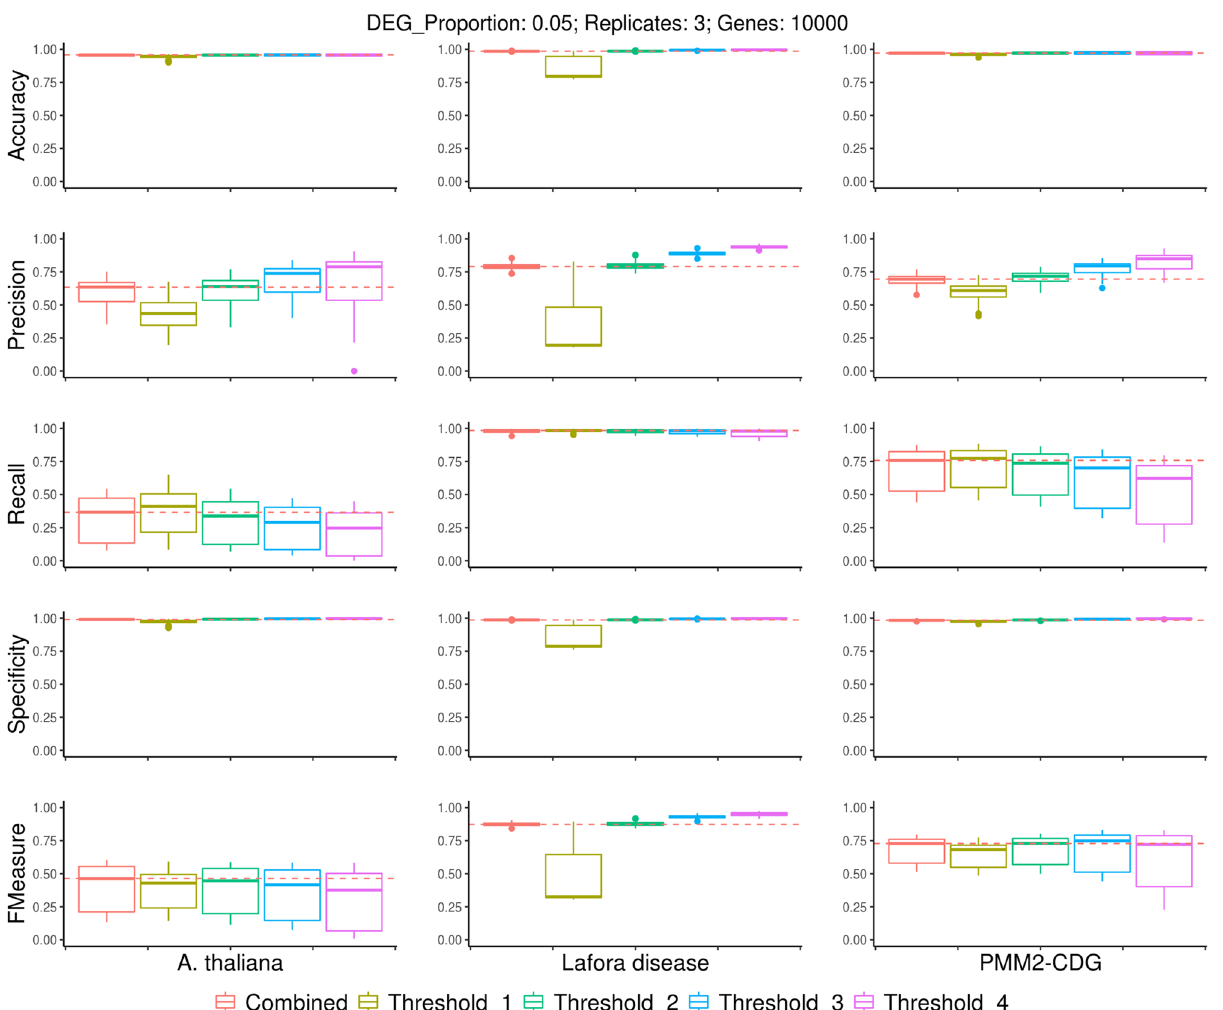
Figure 3. Boxplots showing performance metrics for different combination methods across a range of simulated experiments. The simulated datasets shown included three replicates, 10,000 genes and a simulated DEG proportion of 0.05. Plots are grouped by metric (rows) and experiment (columns). Boxplot colours represent the different combination methods used. The broken horizontal red line represents the median value for the combined-score system. Recall sensitivity, precision positive predictive value (PPV). Threshold refers to the minimum-vote threshold used for combining the results of different